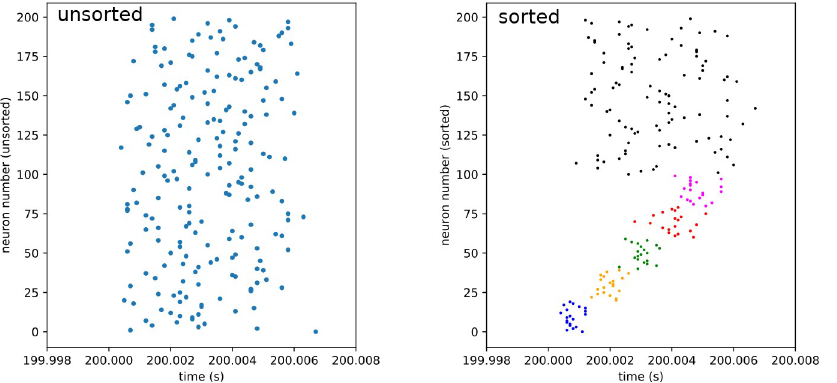
Fig 4. Control activity. Spike raster plots of a section of control activity, demonstrating rapid replay. Time given relative to cue onset. Presented as both unsorted and sorted to demonstrate subtlety of structre. In the sorted case, different population groups, or clusters, are highlighted by different